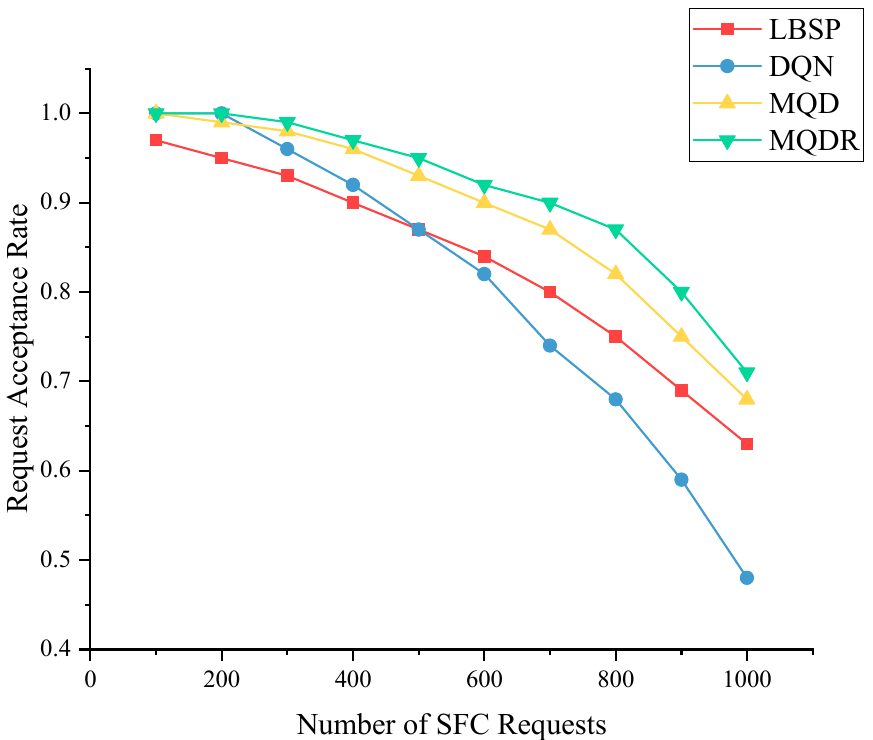
Figure 8. Performance of different algorithms with different number of requests.